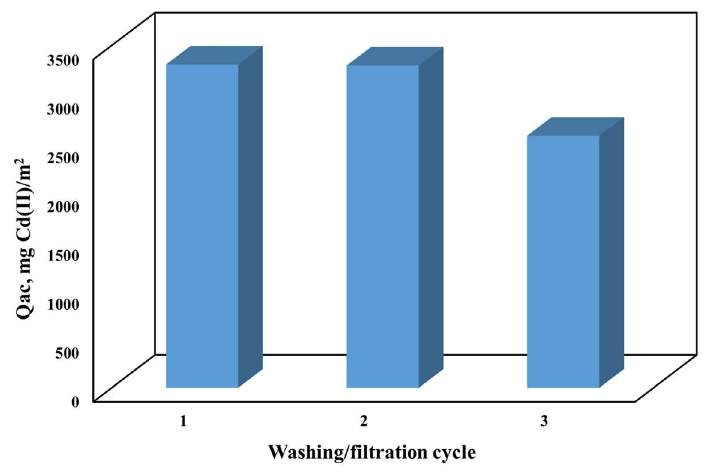
Figure 10. The filtration efficiency of the PIM-Am15 in the treatment process of water with Cd(II) ion content at different washing/filtration cycles.